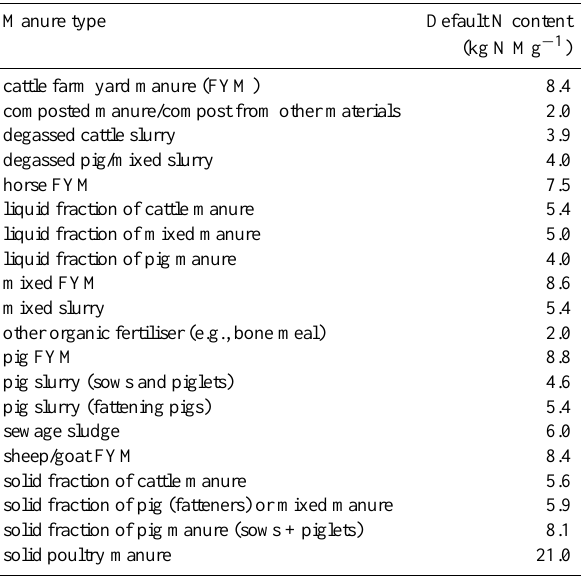
Table 2. Default N contents in imported and exported manure. Manure type